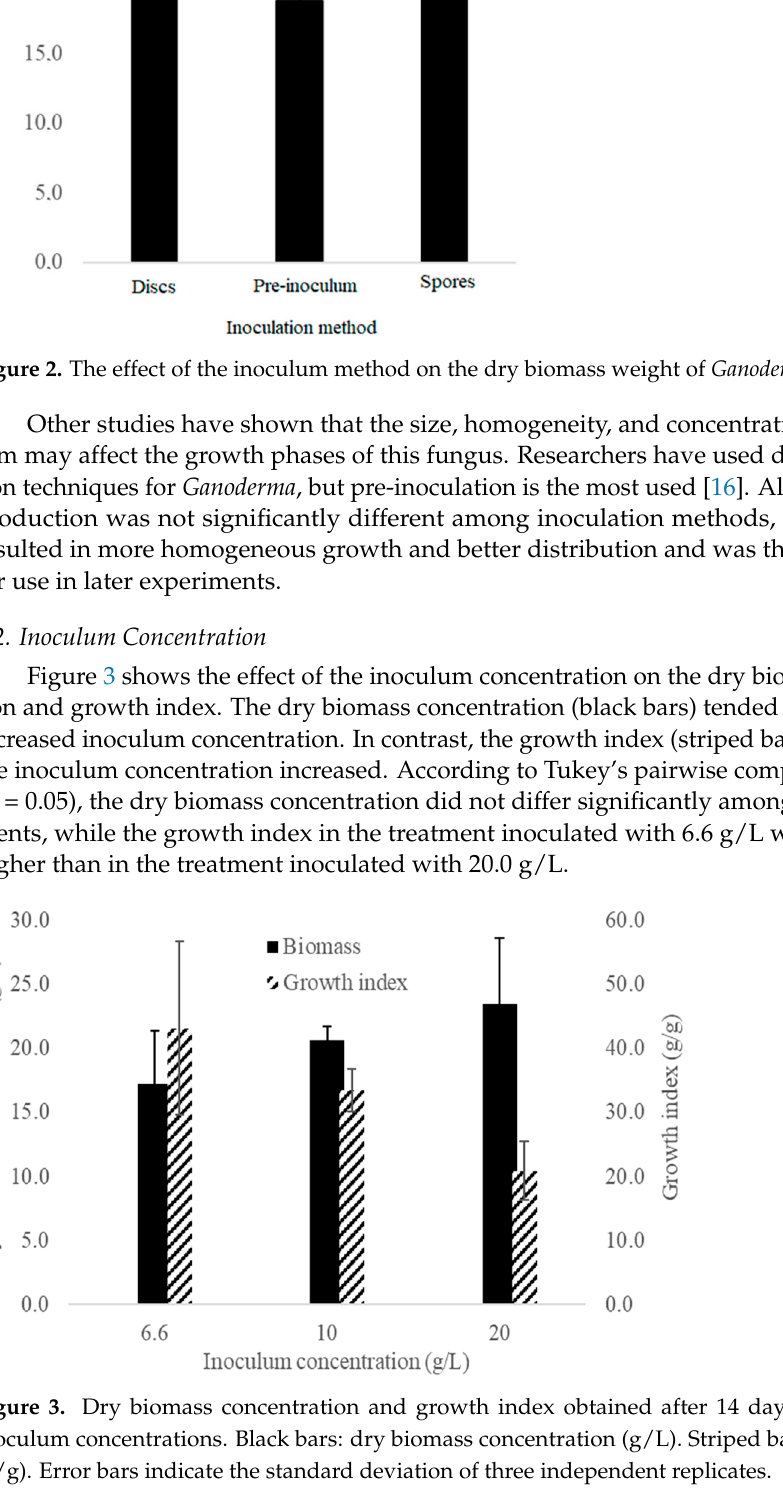
Table 6. Specific growth rate of Ganoderma sp. in the submerged culture obtained from different growth models. Model